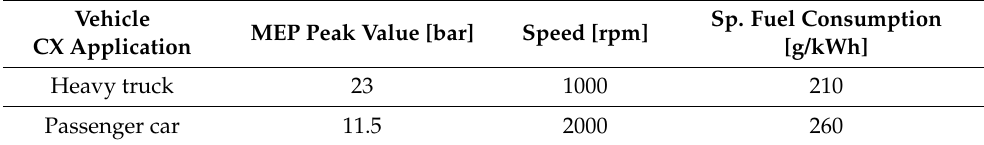
Table 4. Comparison between the two types of Comprex applications